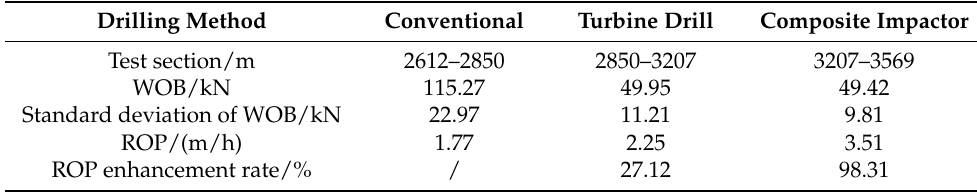
Table 6. Comparison of fi eld test results of di ff erent drilling methods.